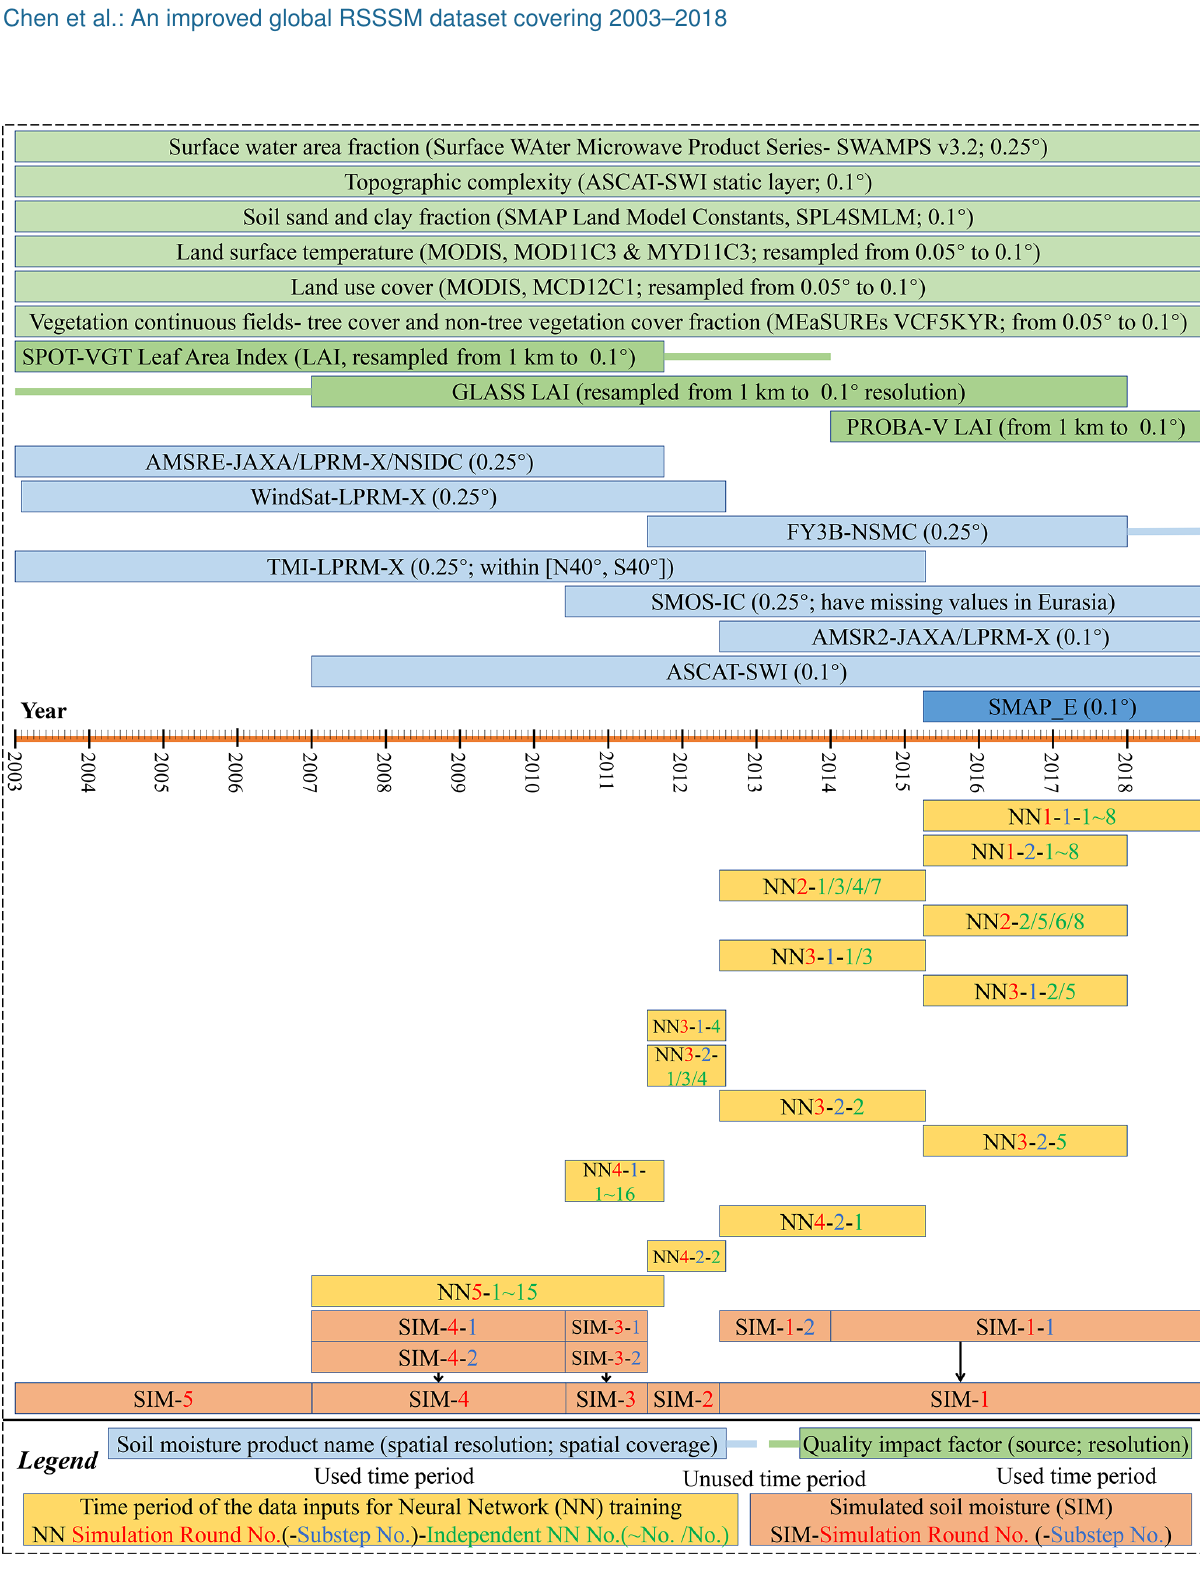
Figure 1. Overview of the time periods of different soil moisture datasets and the “quality impact factor” products (e.g. leaf area index, LAI, dataset) used in this study (listed above the timeline) as well as the periods of data applied for the training of the 67 independent neural networks and the neural network simulation outputs (i.e. simulated soil moisture) in eight substeps (listed below the timeline).